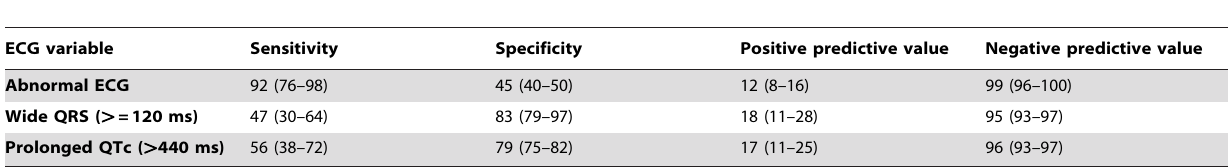
Table 4. Diagnostic performance of selected ECG findings in the recognition of reduced left ventricular ejection fraction ( , 0.50) in T.cruzi seropositive blood